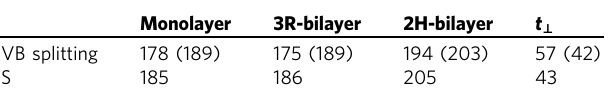
Table 1 Valence band splittings, A – B transition energy differences (S) extracted from GW and GW + BSE calculations and the corresponding interlayer coupling parameters.